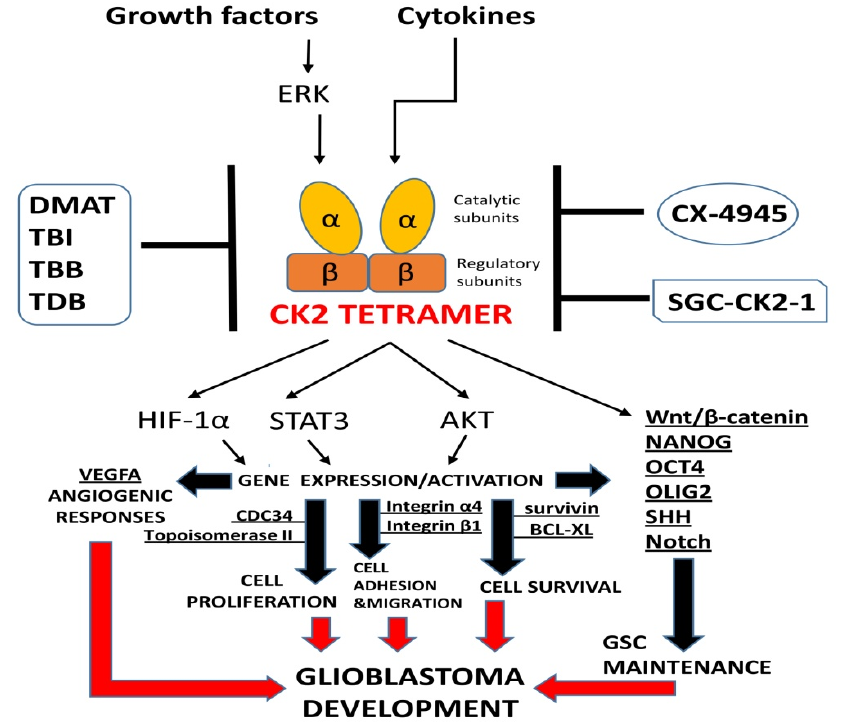
Figure 1. CK2 implications in glioblastoma development. CK2 activity can be stimulated indirectly by growth factors, kinase ERK, and cytokines. Downstream from growth factor signalling, kinase ERK phosphorylates and activates CK2. Activated CK2 regulates AKT and STAT3, HIF-1 α , and GSC maintenance to promote glioblastoma cell adhesion, migration, proliferation, and survival. The action of CK2 may lead, through HIF-1 α and its targets genes VEGF and MMP2 activation, to angiogenic responses and increased invasiveness [59]. Integrin α 4 and Integrin β 1 are responsible for glial